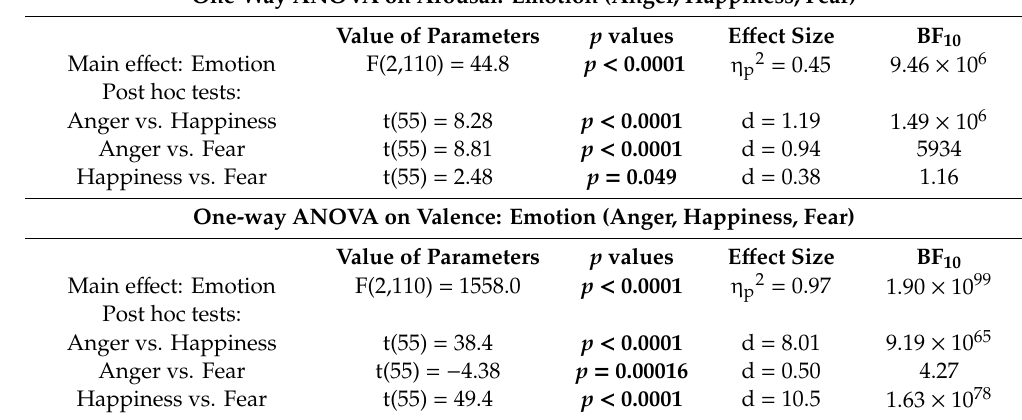
Table 1. Results of the statistical analysis of arousal, valence, and recognizability scores. Post hoc tests (pairwise comparisons) had an adjusted alpha level, according to Bonferroni corrections. Statistically significant results are reported in bold. Bayes factors report the ratio of likelihood of the alternative hypothesis to the likelihood of the null hypothesis (BF 10 ), η p2 , partial eta squared, Cohen’s d, ANOVA, analysis of